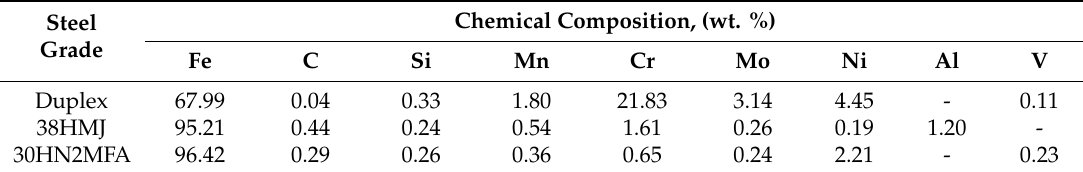
Table 1. Chemical composition of tested steels